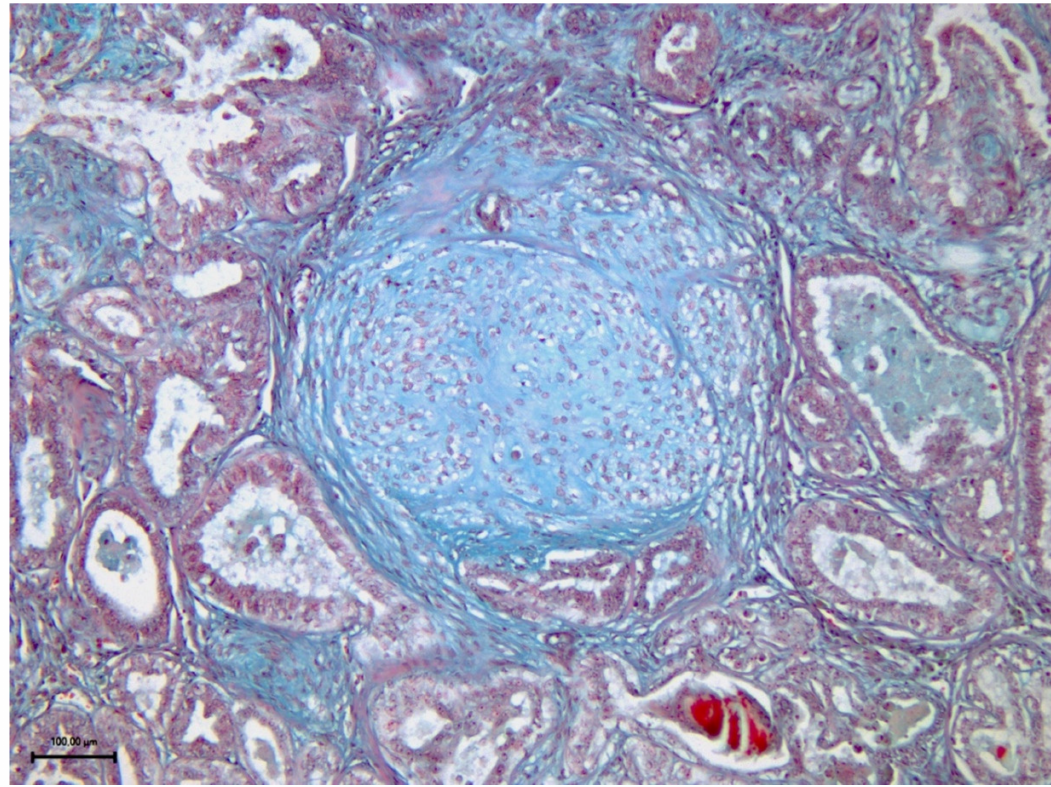
Figure 3. Mucin-rich/collagen-poor ECM in canine mammary lesions. Figure (100 × ) shows the light-blue ground substance of a myoepithelial nest in a mixed carcinoma (sample No.4) stained with Movat